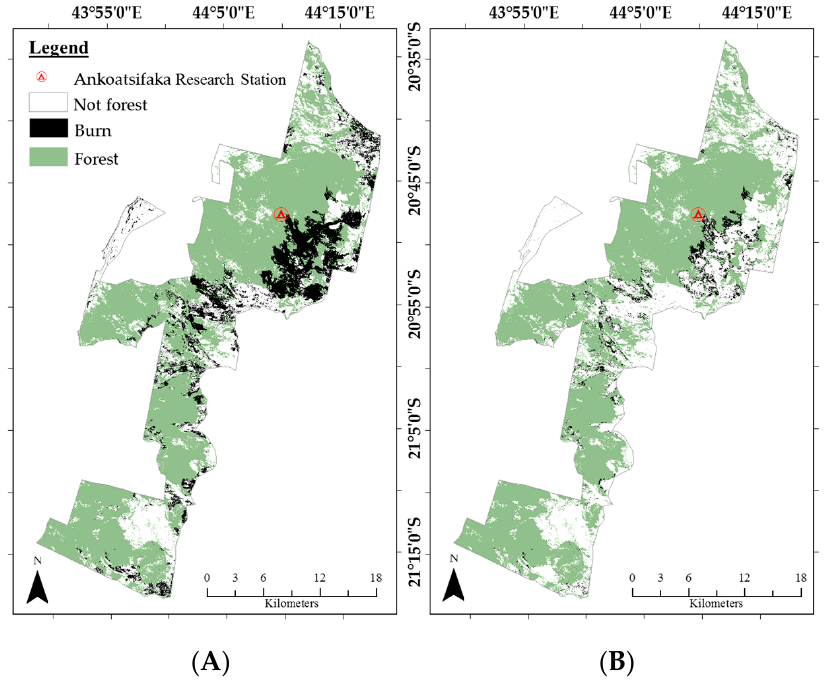
Figure 2. Areas of Kirindy Mitea National Park that burned between 23 June and 27 September 2013. ( A ) total area burned; ( B ) tropical dry forests (TDF) lost to fire.